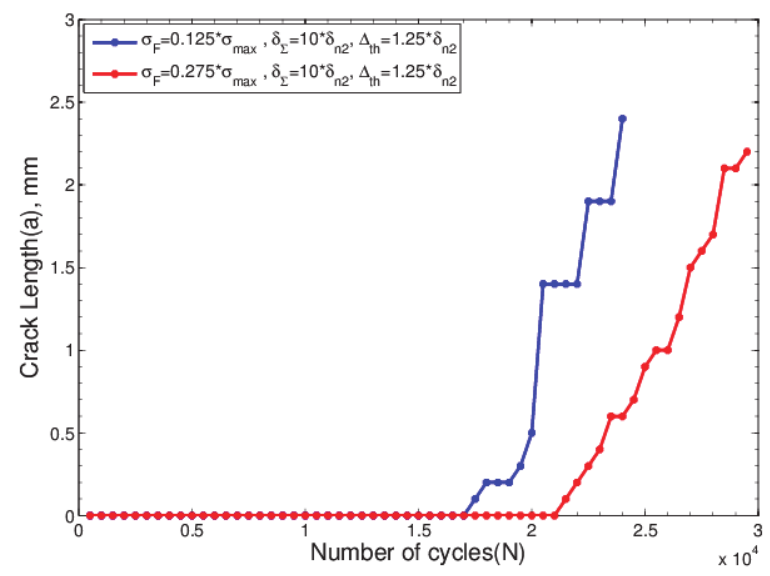
Figure 6: Effect of threshold ( 